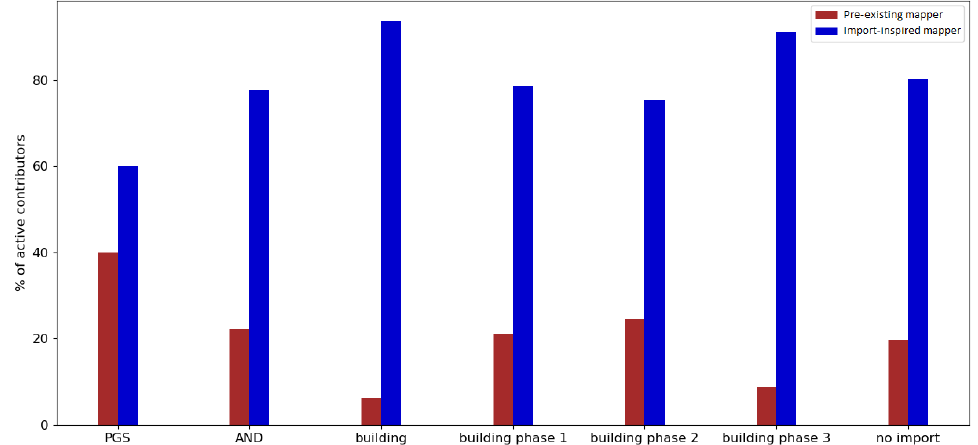
Figure 7. Ratio of pre-existing mappers to import-inspired mappers during an import in India.